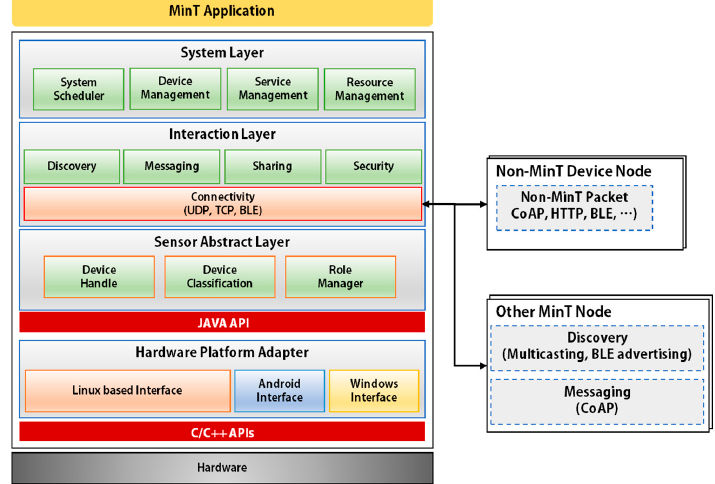
Figure 2. Architecture of MinT.